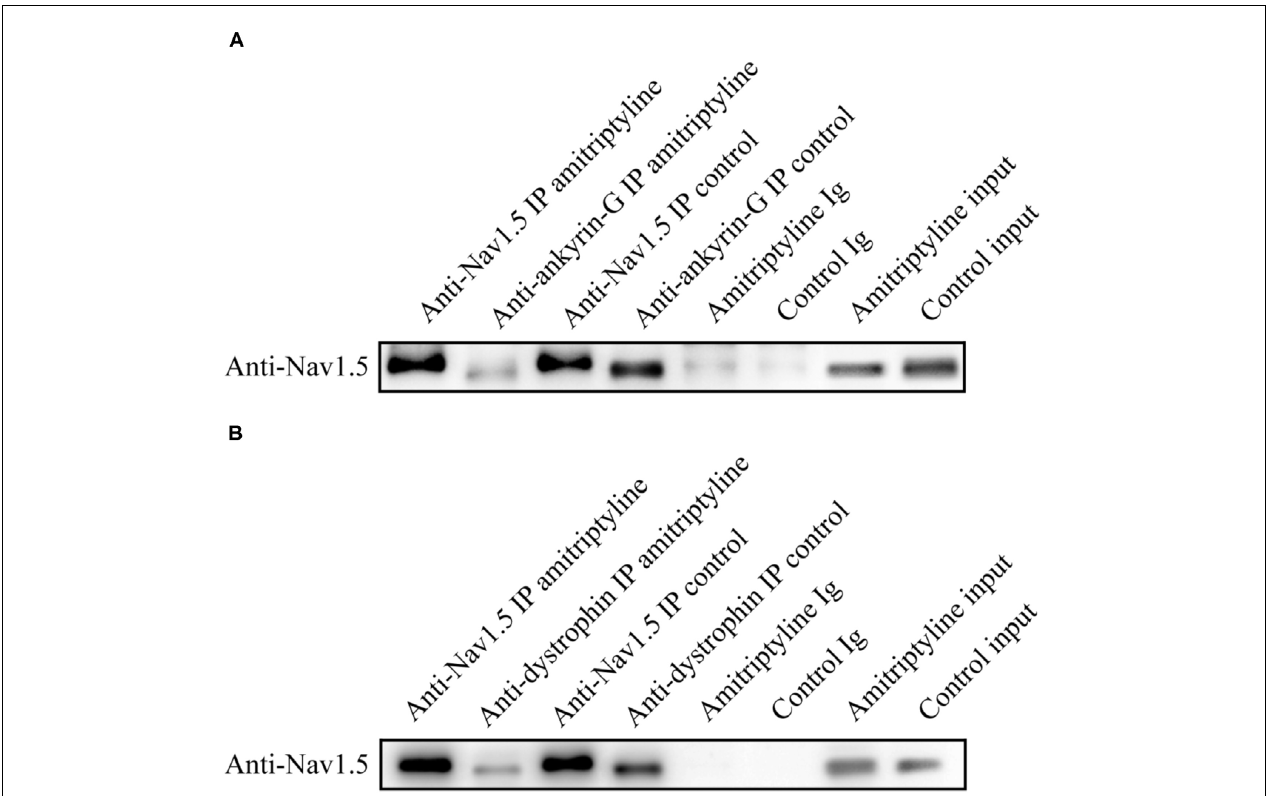
FIGURE 5 | Long-term effect of amitriptyline on the Nav1.5-ankyrin-G interaction and Nav1.5-dystrophin interaction. (A) With the anti-ankyrin-G antibody, Nav1.5 was detectable without long-term treatments with amitriptyline but was not clearly observed after long-term treatments with amitriptyline. (B) With anti-dystrophin antibody, Nav1.5 was detectable without long-term treatments with amitriptyline but was not clearly observed after the long-term treatments with amitriptyline. Input: Western blotting of total protein